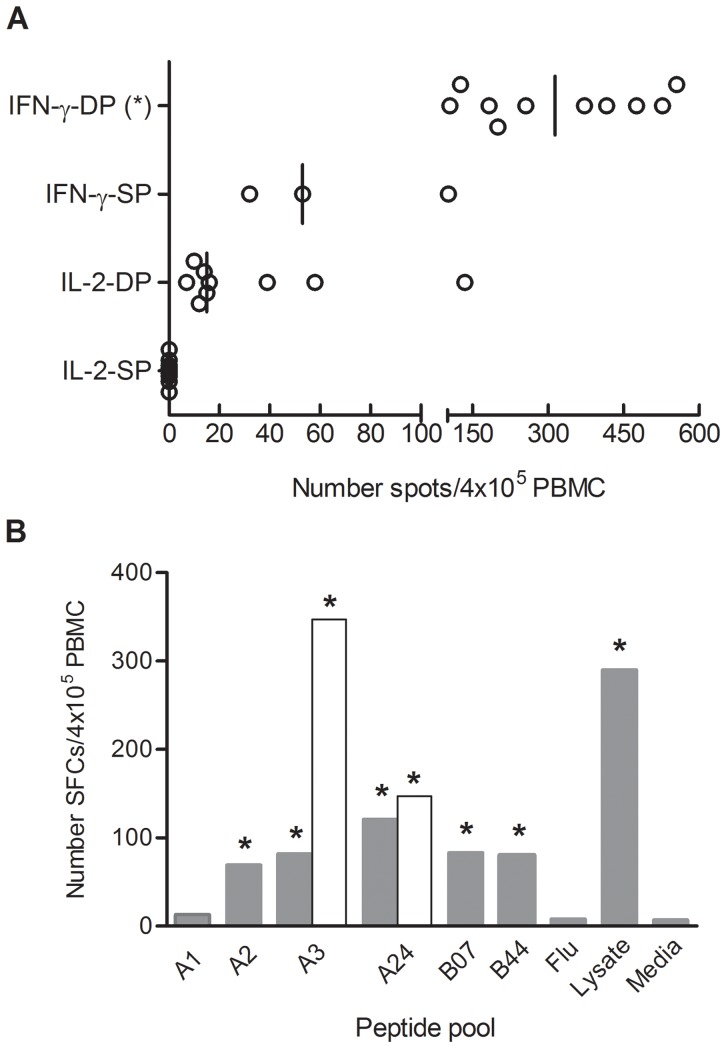
IFN-γ and IL-2-secreting cells in response to Trypanosoma cruzi antigens in T. cruzi-infected children.PBMC from T. cruzi-infected children were seeded at 4×105 cells/well and stimulated with a T. cruzi lysate from the Brazil strain, class-I-restricted HLA-A01, HLA-A02, HLA-A03, HLA-A24, HLA-B07 and HLA-B44 supertype trans-sialidase peptide pools, class-I-restricted Flu-derived peptides or media alone for 16–20 h. (A) T cell responses to a T. cruzi lysate preparation. Each circle represents the mean spot number of triplicate wells for each patient with positive ELISPOT responses out of seventeen assessed. Spot counts with media alone were subtracted. Vertical lines depicting median values are shown. IFN-γ-DP, no. of IFN-γ spots in individuals with positive responses for both IFN-γ and IL-2 ELISPOT assays; IFN-γ-SP, no. of IFN-γ spots in individuals with positive ELISPOT responses for IFN-γ alone; IL-2-DP, no. of IL-2 spots in individuals with positive responses for both IFN-γ and IL-2 ELISPOT assays; IL-2-SP, no. of IL-2 spots in individuals with positive ELISPOT responses for IL-2 alone. (*) P<0.01 vs. IL-2-DP; vs. IL-2-SP and vs. IFN-γ-SP by the Kruskal-Wallis test with Dunn correction. (B) Class I-restricted IFN- γ and IL-2 ELISPOT responses to trans-sialidase peptides. Representative positive ELISPOT responses for IFN-γ (grey bars) and IL-2 (white bars) in a single subject are shown. (*) Indicates positive responses, as defined in the Materials and Methods.